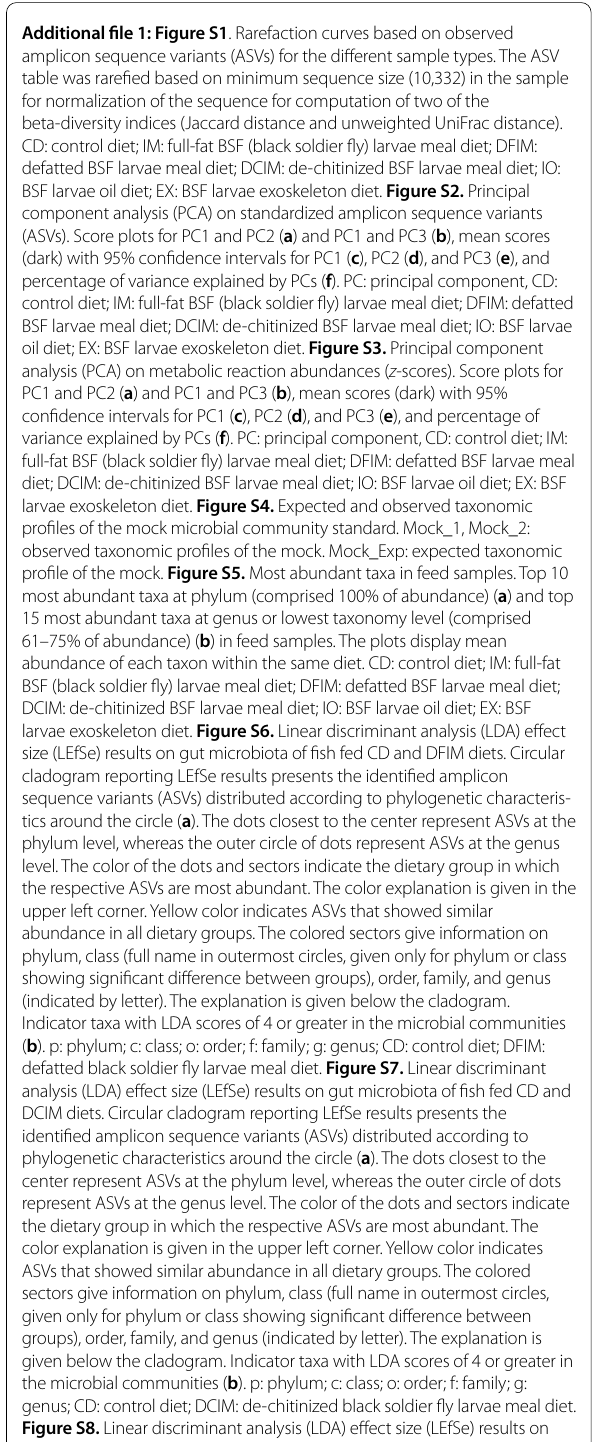
Figure S8. Linear discriminant analysis (LDA) effect size (LEfSe) results on gut microbiota of fish fed CD and EX diets. Circular cladogram